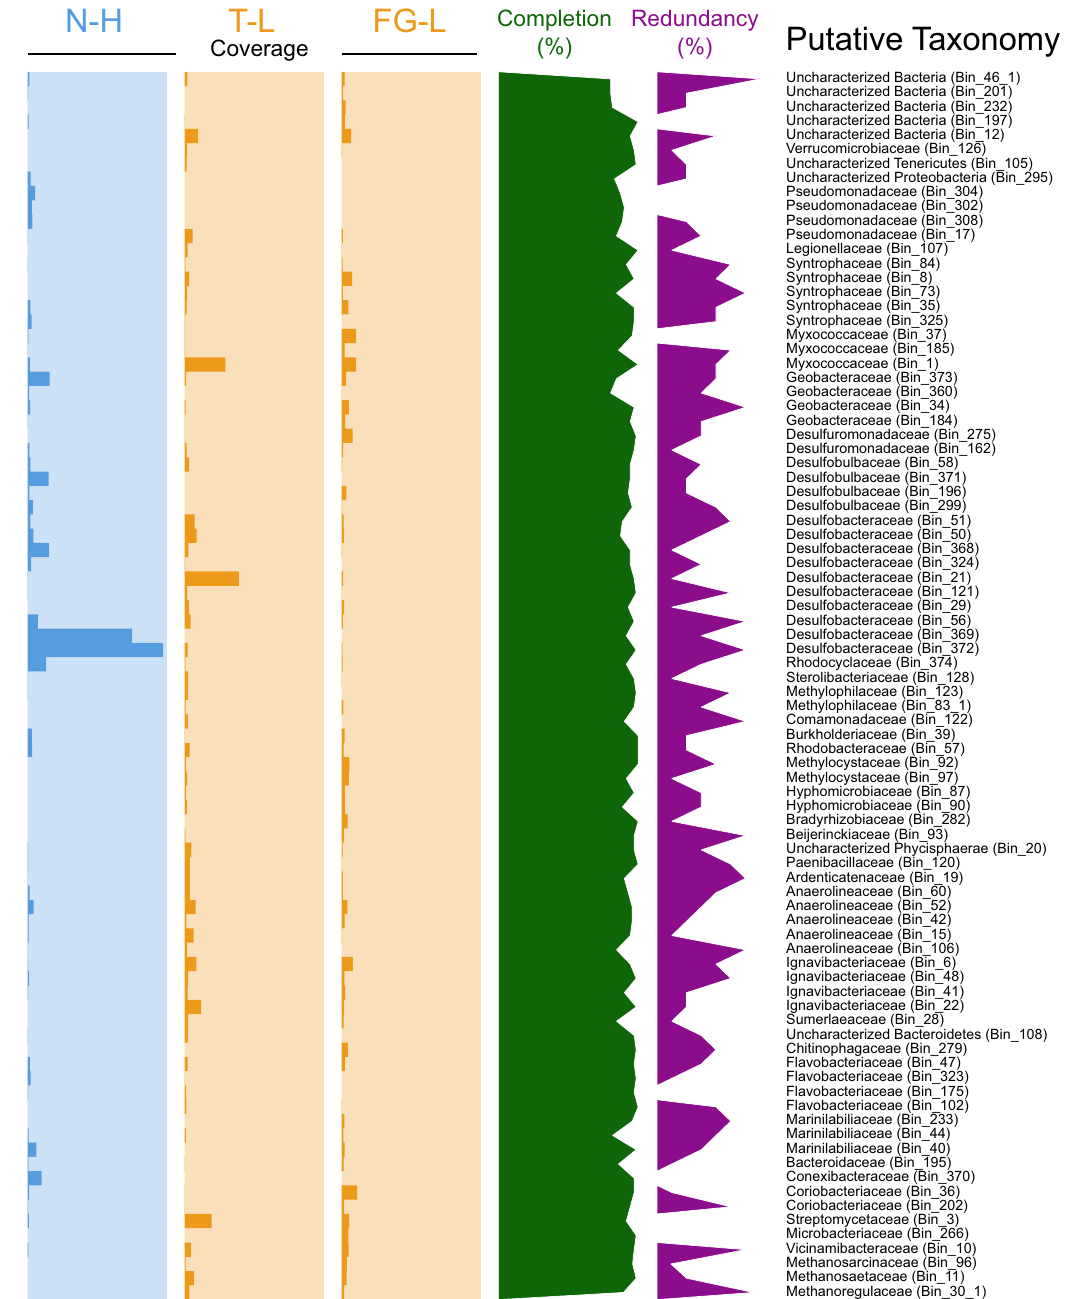
Fig. 2 Coverage comparison of individual metagenome-assembled genomes (MAGs). MAGs with greater than 80% completion (green line graph; axis from 0 – 100%) from one high-sulfate coal seam (N-H in blue) and two low-sulfate coal seams (FG-L and T-L in orange) were compared. Coverage is calculated by fi nding the average depth of coverage across all contigs using Anvi ’ o compiled contigs. Coverage bar graphs axis (from 0 to 550×) is indicated with the highest possible sequencing depth being 550. All samples were below 10% redundancy (purple line graph; axis 0 – 10%). Taxonomies are listed based on